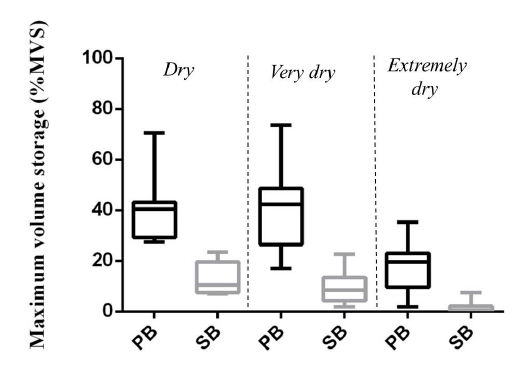
Figure 2. Variation of the percent of maximum volume stored (%MVS) in the reservoirs during the dry, very dry and extremely dry seasons. Bands inside the boxplots represent their medians and vertical bars represent minimum and maximum values. PB – Piancó basin; SB – Seridó